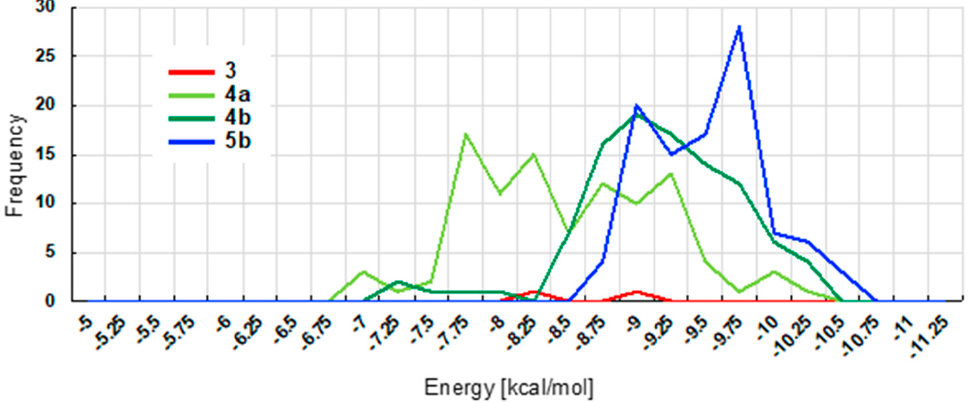
Figure 4. Distribution of docking energies of the top 100 poses of 3 , 4a , 4b , and 5b with parallel-type telomeric G4. telomeric G4.